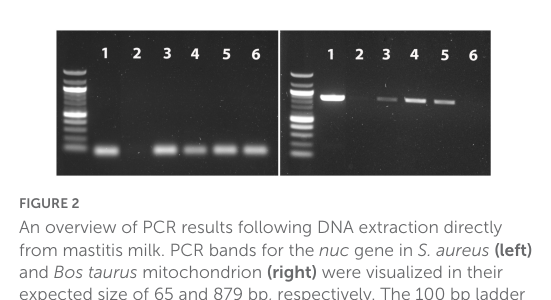
FIGURE2 An overview of PCR results following DNA extraction directly from mastitis milk. PCR bands for the nuc gene in S. aureus (left) and Bos taurus mitochondrion (right) were visualized in their expected size of 65 and 879 bp, respectively. The 100 bp ladder was also used.1: Mol Com5 cent , 2: Mol Plus cent , 3: Mol Com5 cent − nuc , 4: Mol Plus cent − nuc , 5: Mol Com5 cent − ox − nuc , 6: Mol Plus cent − ox − nuc .